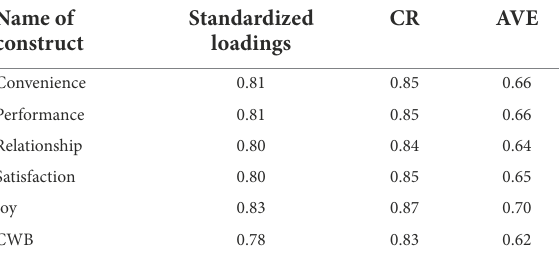
TABLE 3 Results of the measurement properties.